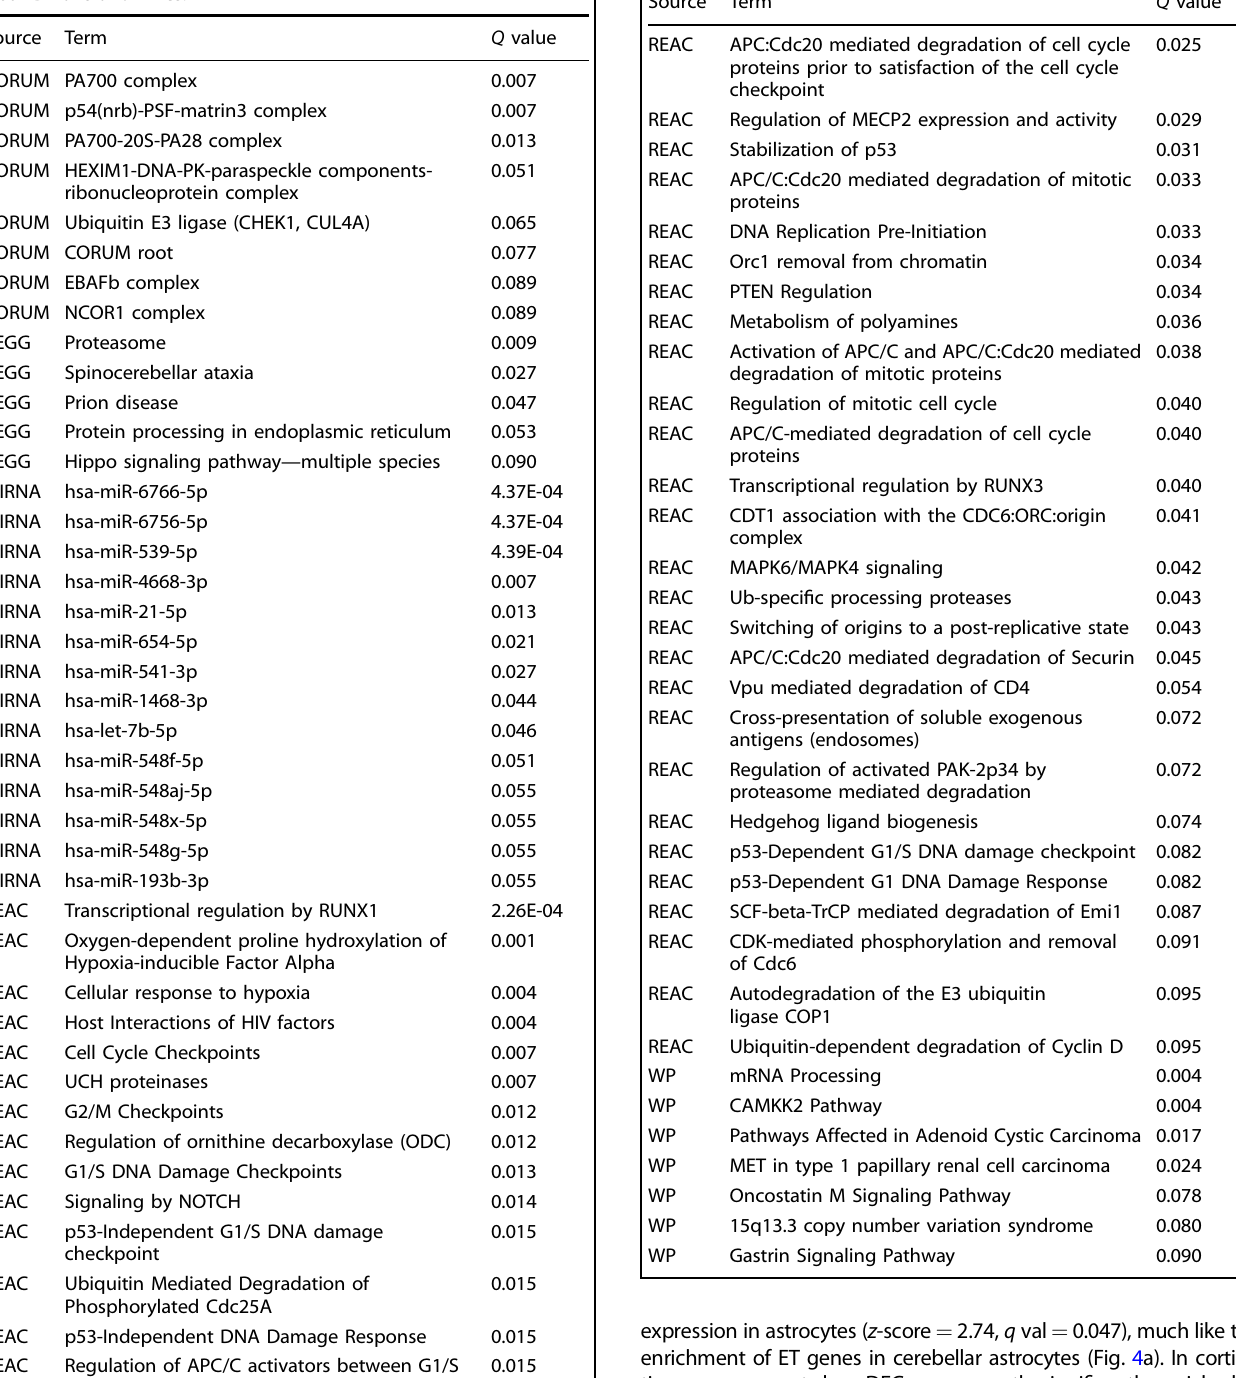
Table 2. Pathway enrichment for convergent propranolol DEGs in both DAOYs and